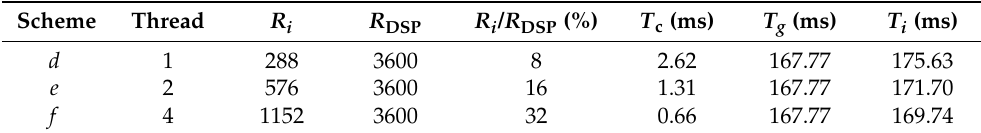
Table 4. Theoretical resource usage and calculation time with different threads in coarse